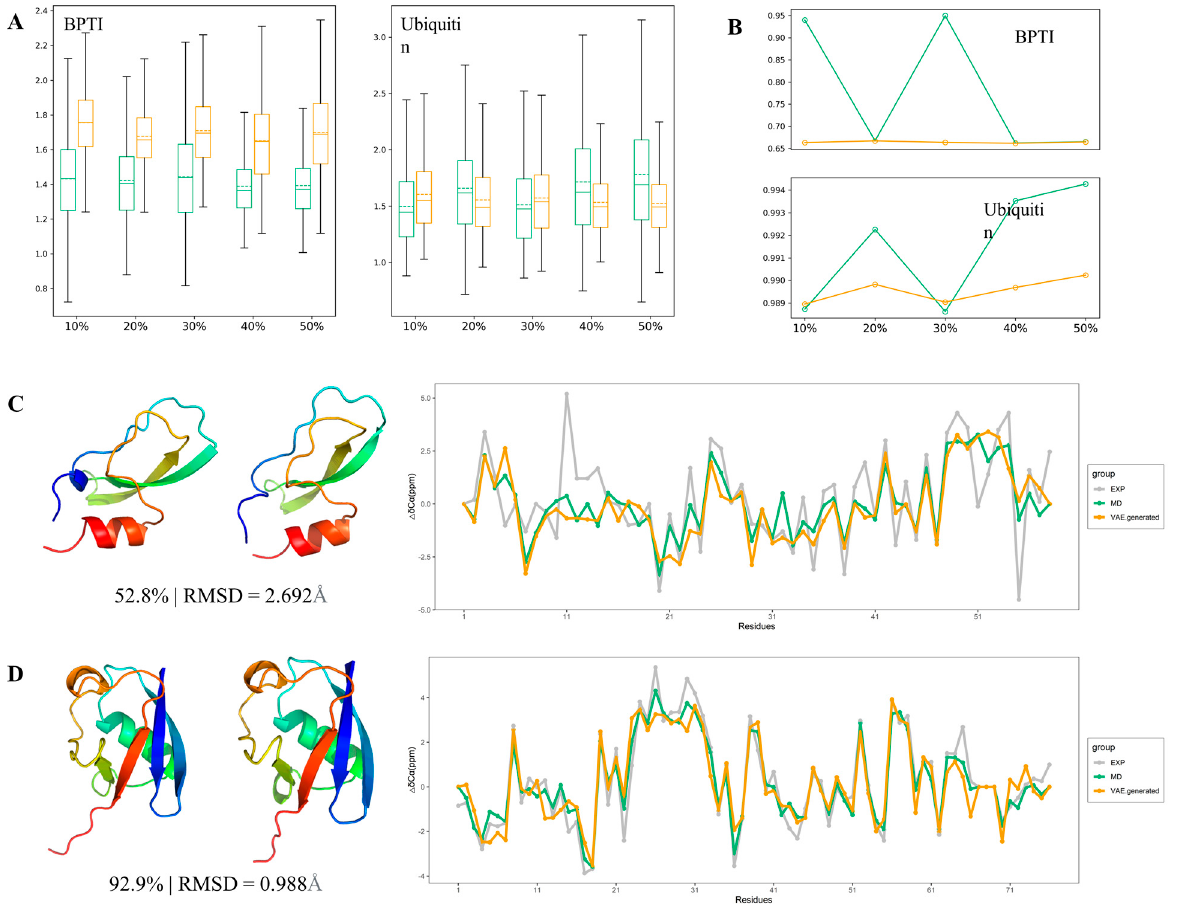
Figure 6. Tests of VAEs’ performance on structured proteins. ( A ) RMSD between original conformations and generated ones. ( B ) Spearman correlation coefficient. ( C ) structures and chemical shifts of BPTI. ( D ) structures and chemical shifts of ubiquitin.